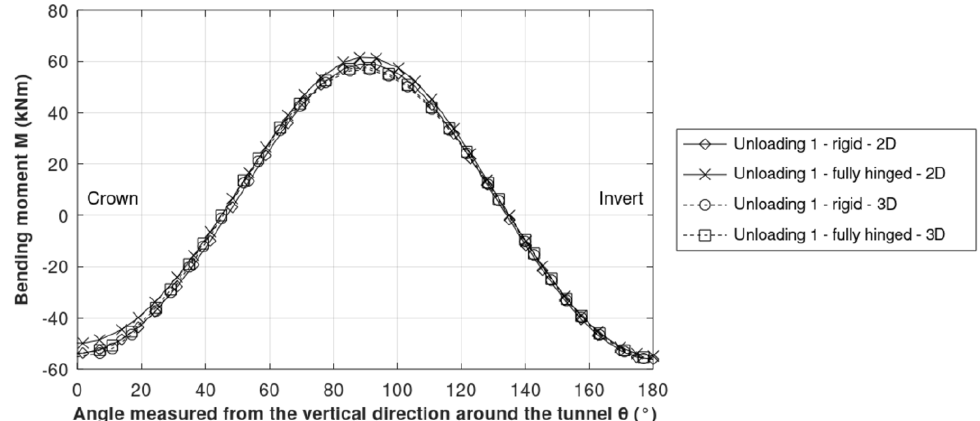
Fig. 10. Bending moments considering different joint configurations (unloading conditions).